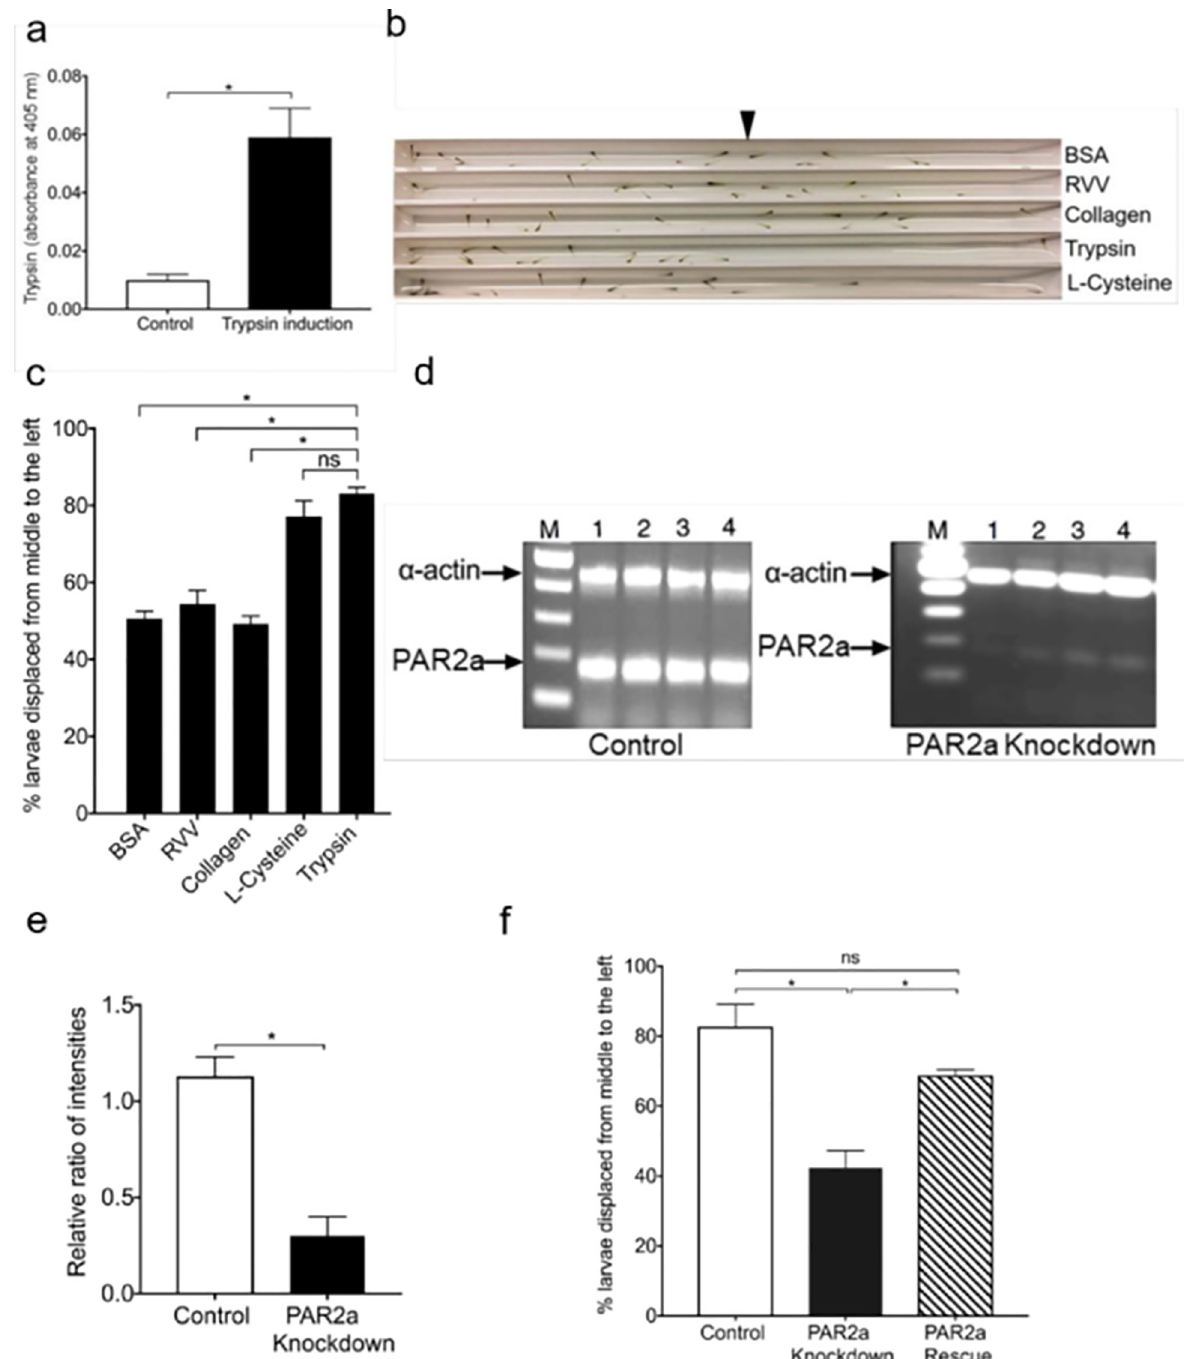
Fig 1. Aversive responses of zebrafish to trypsin. a . Trypsin released by zebrafish in response to trypsin itself. Absorbance at 405 nm represents the yellow color generated by digestion of the s-2238 substrate by trypsin. (n = 6 independent experiments; For each experiment 1 fish was used; � p < 0.001). b . A representative photograph showing the dispersion of larvae in the elongated mini-tanks after the larvae were introduced to the tank at the midpoint (arrowhead) followed by injection of test chemicals on the rightmost end of each tank. The test chemicals were BSA, RVV, collagen, trypsin, and L-cysteine. Note the movement of larvae to the left side of the tanks away from trypsin and L-cysteine. c. Quantification of dispersion as the % larvae displaced from the middle to the left side in the mini-tanks in response to BSA, RVV, Collagen, Trypsin, and L-Cysteine. (n = 6 experiments; � p < 0.001; ns, non-significant). d. par2a transcripts were decreased markedly in the par2a knockdown zebrafish larvae (7 dpf). Results of RT-PCR with α -actin serving as the internal control and DNA size markers in lane M. Lanes 1–4 each represent mRNA from one animal. Control and par2a knockdown embryos were injected with sense cSO/cVMO and antisense aSO/cVMO hybrids for the piggyback knockdown. e.